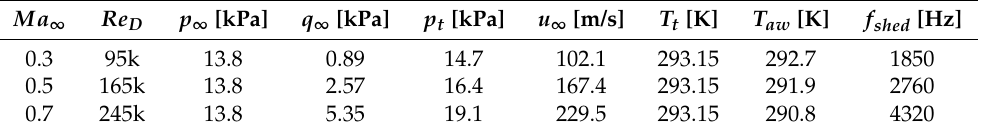
Table 1. Aerodynamic operating conditions for the high-speed TSP measurements. Adiabatic wall temperatures assume turbulent boundary layer states at the position of the reference sensor and a recovery factor of r = 0.91 for all operating points.